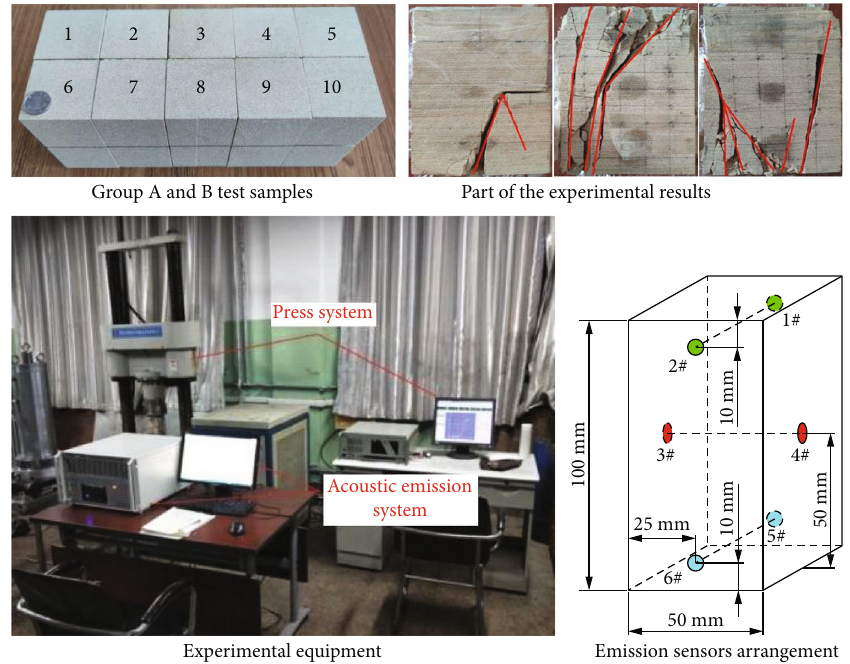
Figure 1: Samples, experimental results, experimental equipment, and acoustic emission sensor arrangement.